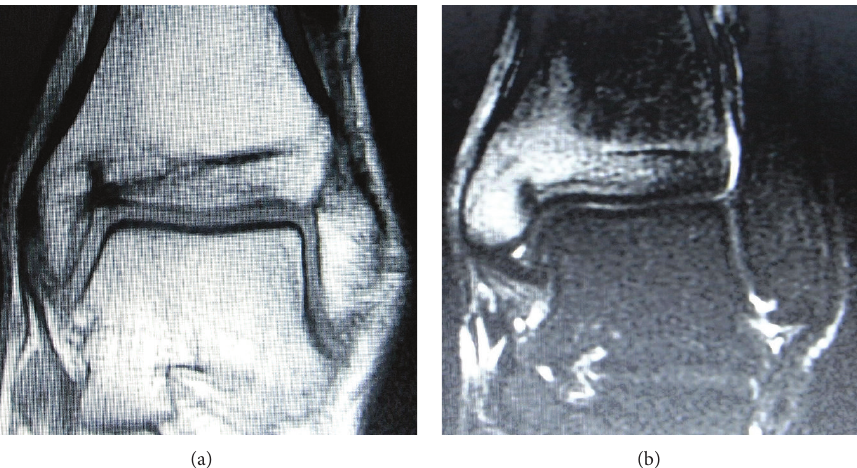
Figure 1: (a) T1-weighted MR image demonstrates a vertical linear lesion of low signal intensity originating from the superomedial corner of the ankle. (b) STIR (short T1 inversion recovery) image reveals bone marrow edema surrounding the linear lesion.